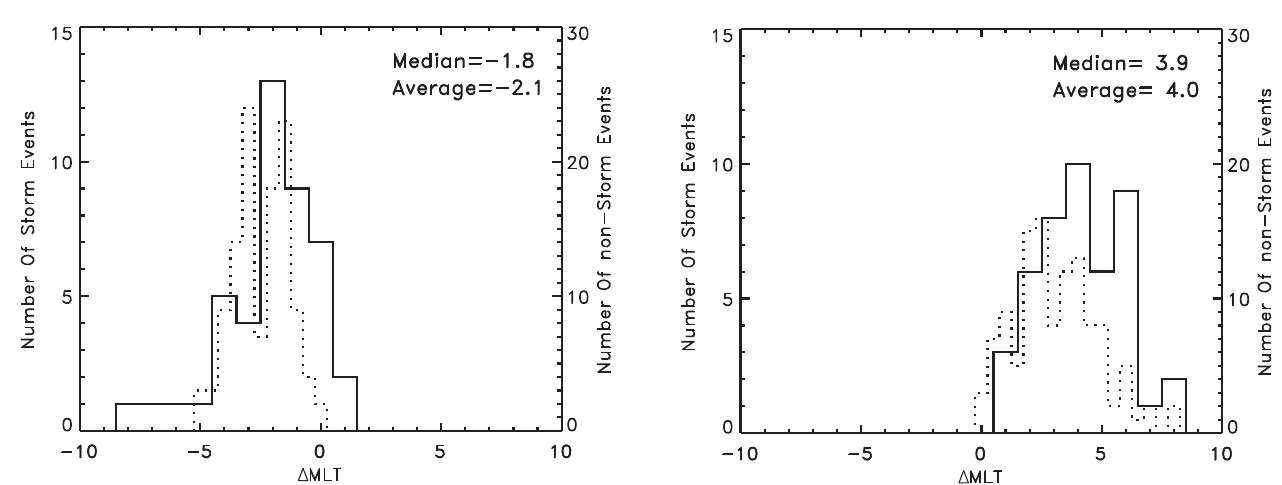
Fig. 8. Histogram of the number of substorms as a function of expansion from a localized onset to the maximum expansion in 1 MLT, westward expansion on the left, eastward expansion on the right. Superimposed are similar histograms for isolated substorms (dotted lines), the west end of the bulge, or surge head (left), and the east end of the oval aurora (right) (from Gjerloev et al.,